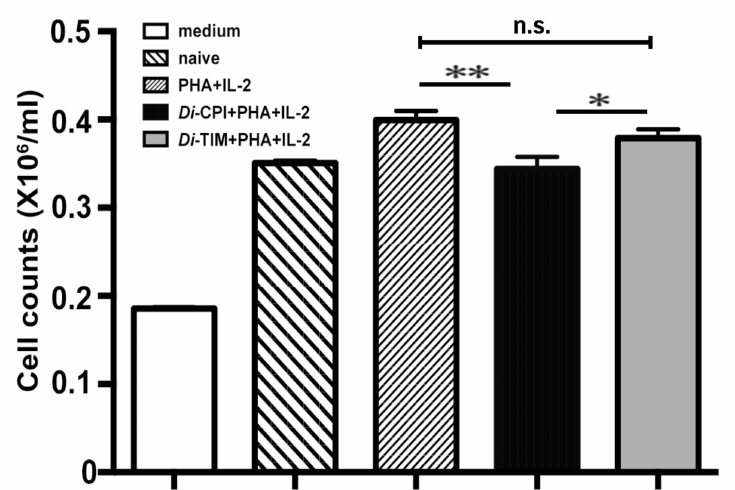
Figure 5. Inhibition on the proliferation of canine peripheral blood mononuclear cells (PBMCs) by Di -CPI. Canine T cells were stimulated with PHA + IL-2, PHA + IL-2 + r Di -CPI, or PHA + IL-2 + r Di- TIM for 48 h as determined by CCK-8. Di -CPI inhibited the proliferation of canine T cells by 15% compared with naive controls and 10% compared with Di -TIM controls. Naive indicates no protein was added to wells. Data are mean ± SEM of 3 samples with triplicate wells; representative data from one of three independent experiments. Statistically significant di ff erences (* p < 0.05, ** p < 0.01) were determined by Student’s t